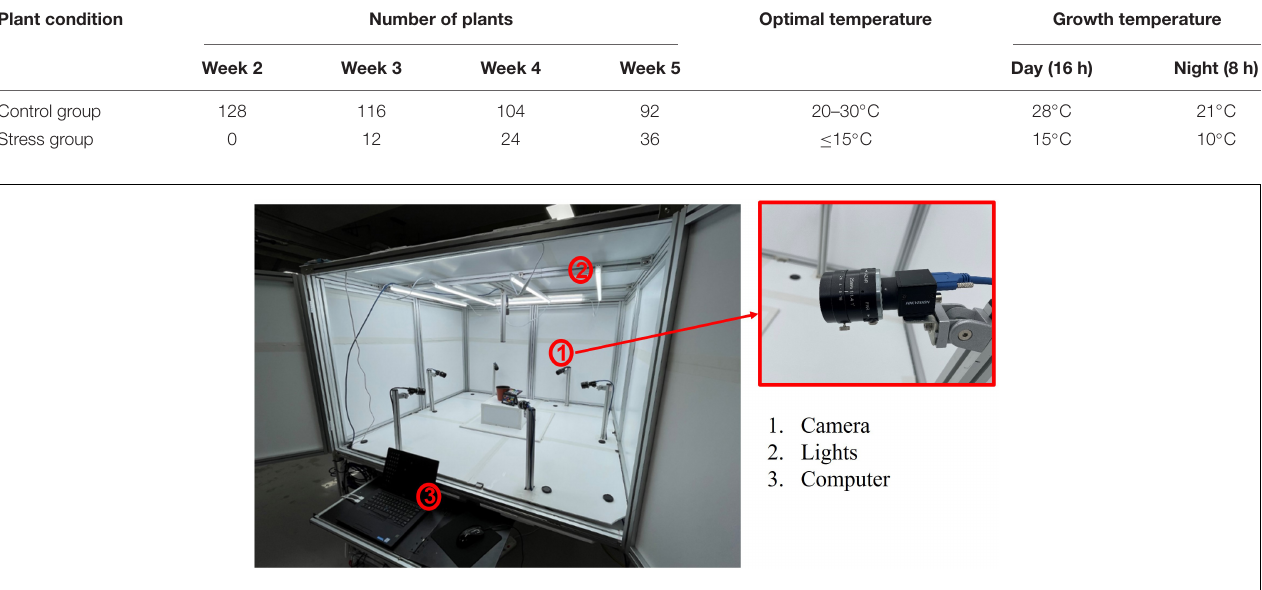
TABLE 1 | Plant growth conditions and weekly stress plan.